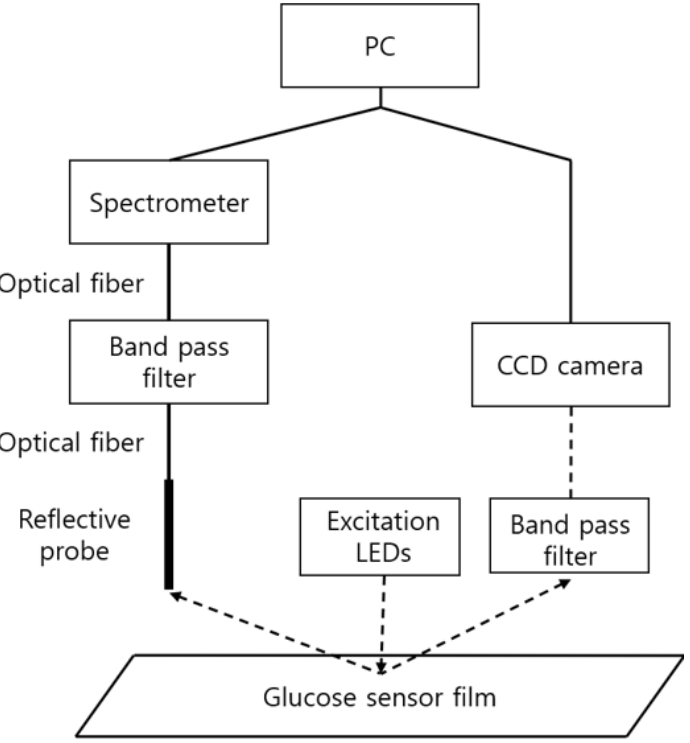
Figure 3. Measurement components for spectrometry and photometry. The left side shows the con- nection diagram of the components for spectrometry and the right side the photometry connection diagram.